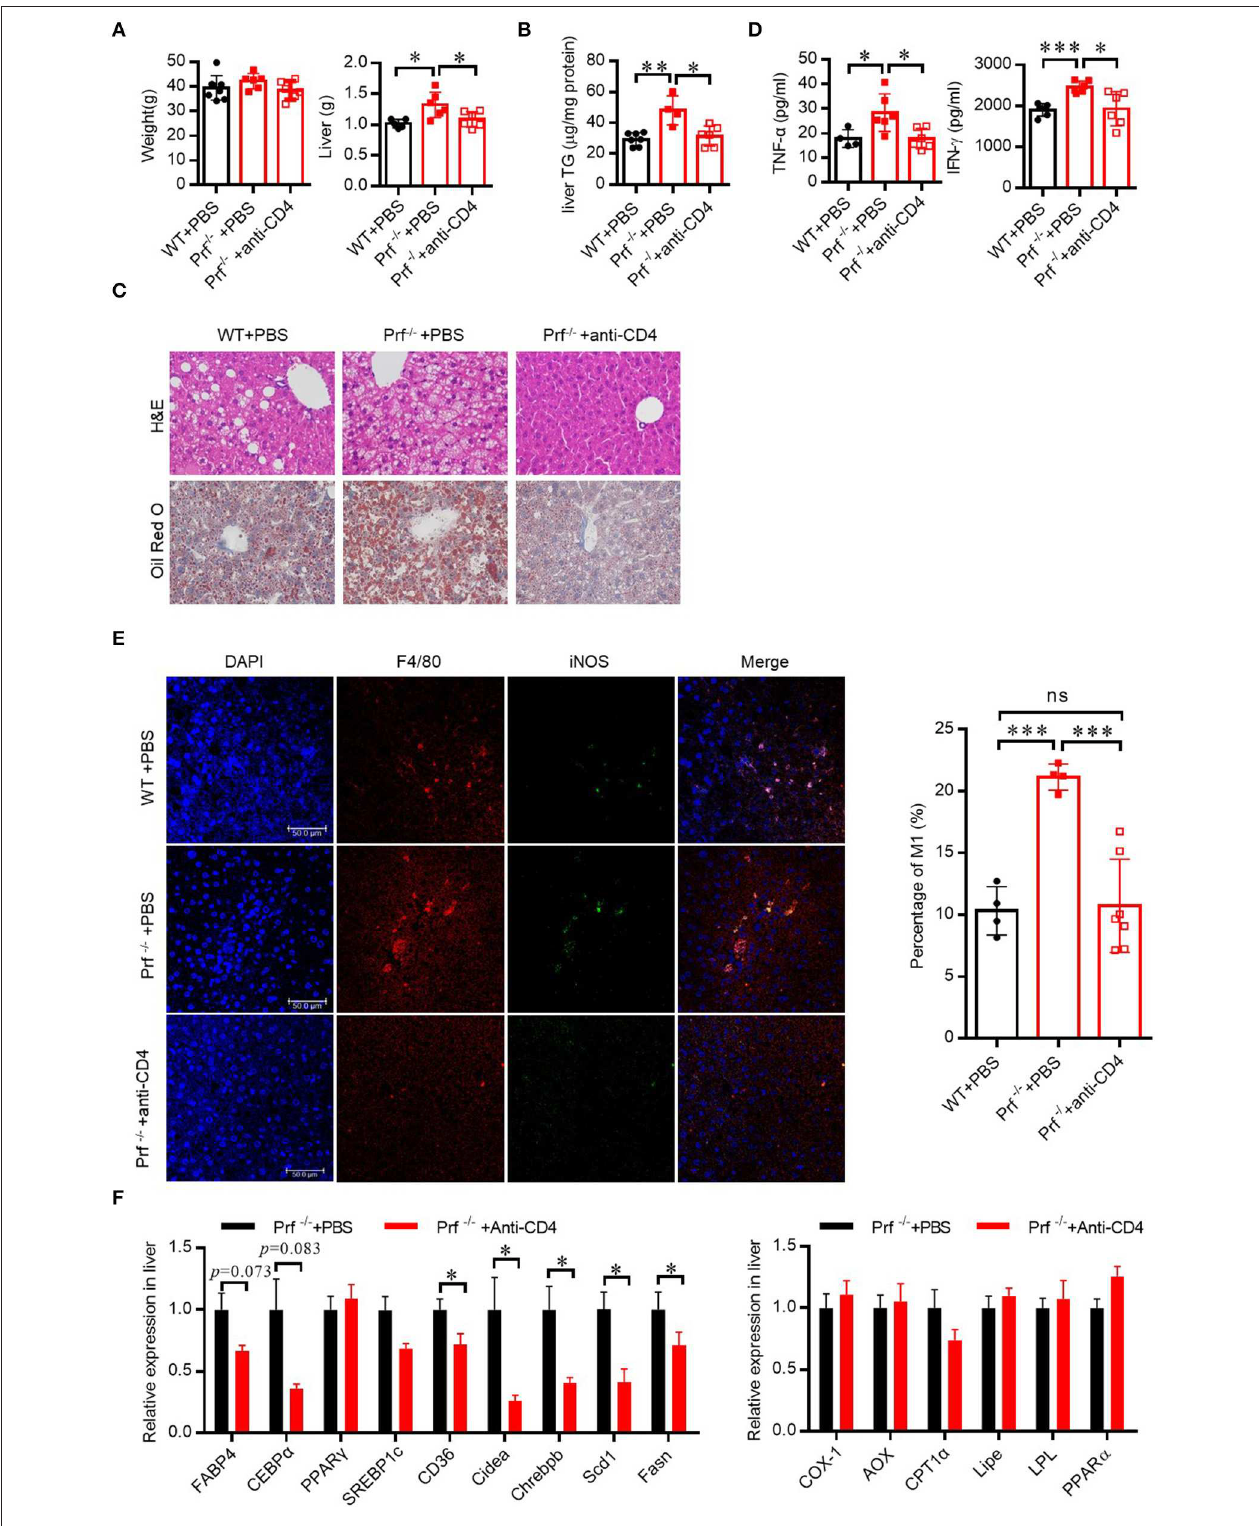
FIGURE 5 | Perforin regulates fatty liver disease through CD4T cells in the liver. WT and Prf − / − mice were injected with PBS, or Prf − / − mice were injected with an anti-CD4 antibody weekly during 10 weeks of HFD challenge . (A) Body and liver weight were measured ( n = 6–8). (B) Measurements of liver TG content ( n = 4–7).